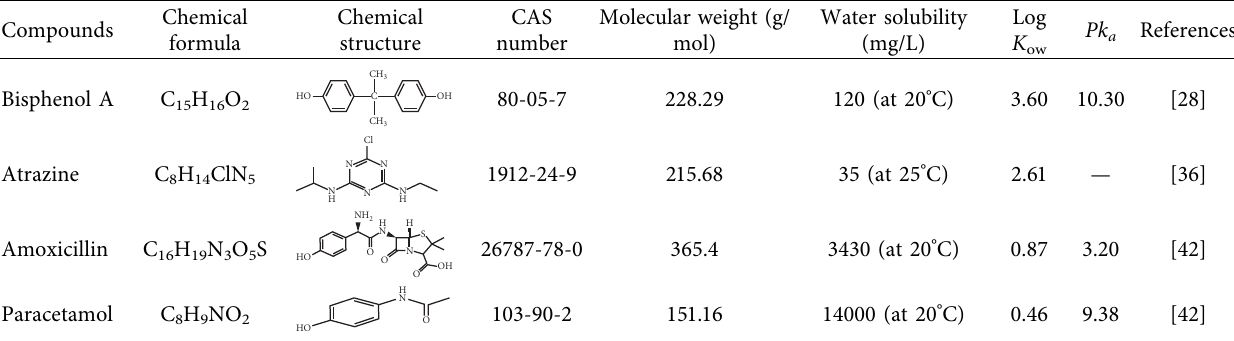
Table 1: Physicochemical properties of bisphenol A, atrazine, amoxicillin, and